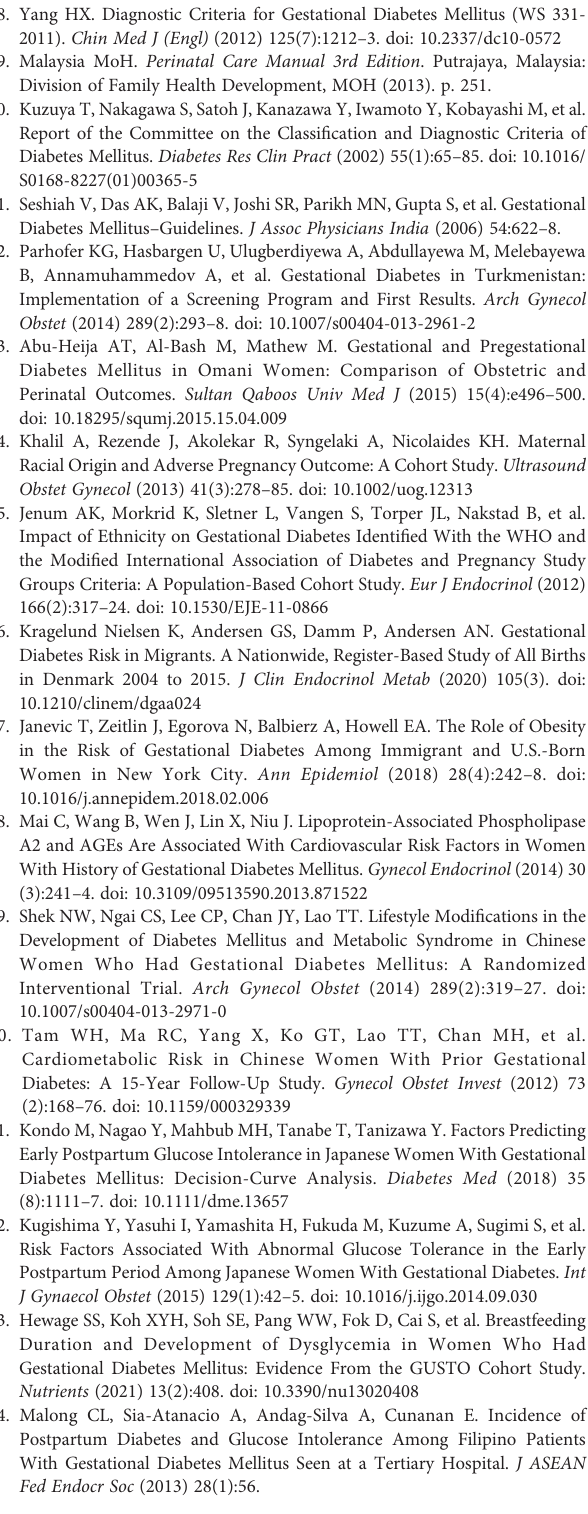
Supplementary Figure 2 | Flow diagram of search strategy and selection of GDM-related maternal postpartum health outcomes in the Asian population including Native Asians and Asian migrants.